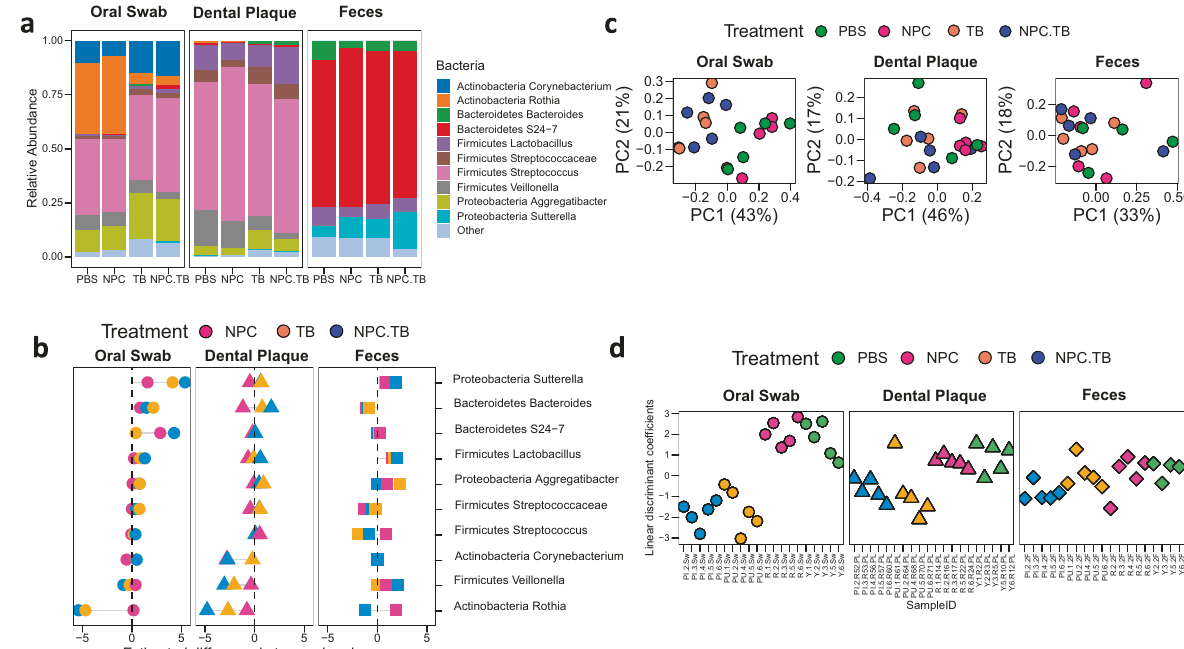
Fig. 3 Effects of repurposed drug treatment on oral and gut microbiomes. a Bacteria relative abundances within rodent body sites for each treatment group. b Fold change estimate showing main bacterial genera that were differentially abundant between treatment groups against baseline (PBS). c Bray – Curtis principal coordinate analysis for each body site. Color samples correspond to treatment groups. d Linear discriminant coef fi cients obtained for treatment model. Higher coef fi cients indicate samples more likely to have non-TB treatments (PBS and NPC groups), while lower numbers indicate samples more likely treated with TB (NPC.TB and TB